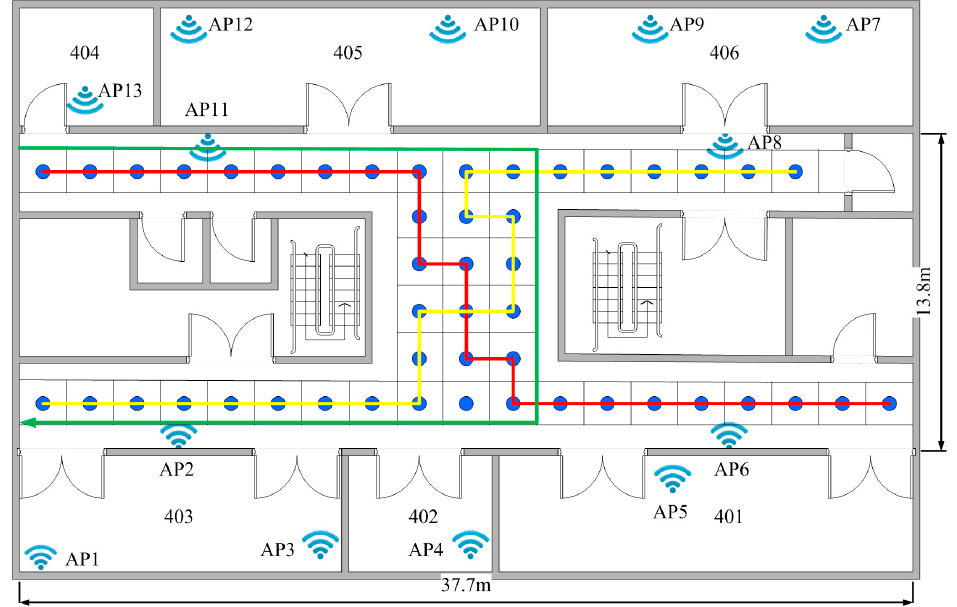
Figure 8. The layout of the fourth floor of the YiFu building.